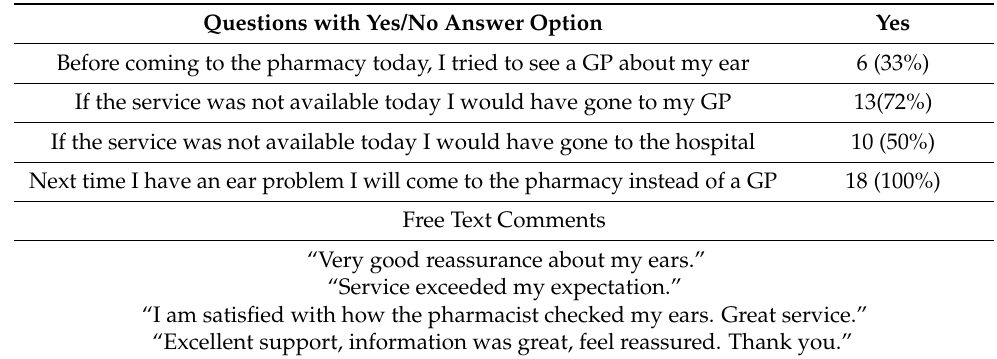
Table 4. Patient satisfaction survey